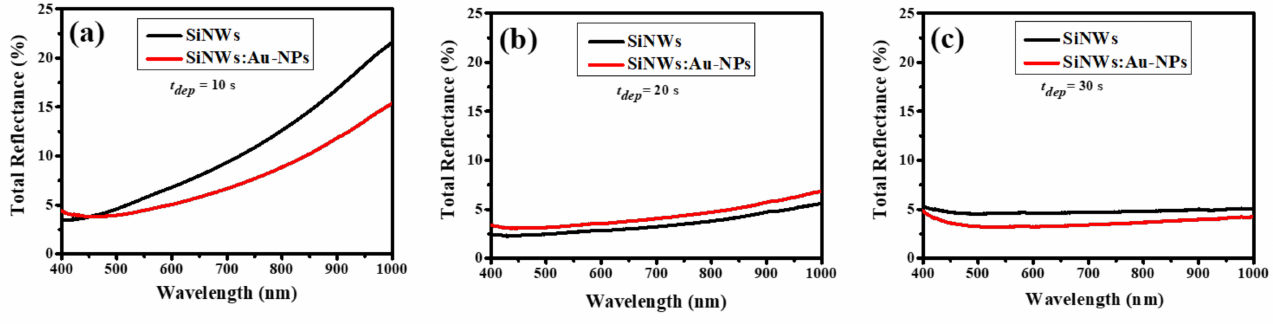
Figure 5. Spectra of the total reflectance for SiNWs and SiNWs:Au-NPs with different t dep ( a ) 10 s; ( b ) 20 s; ( c ) 30 s, respectively.